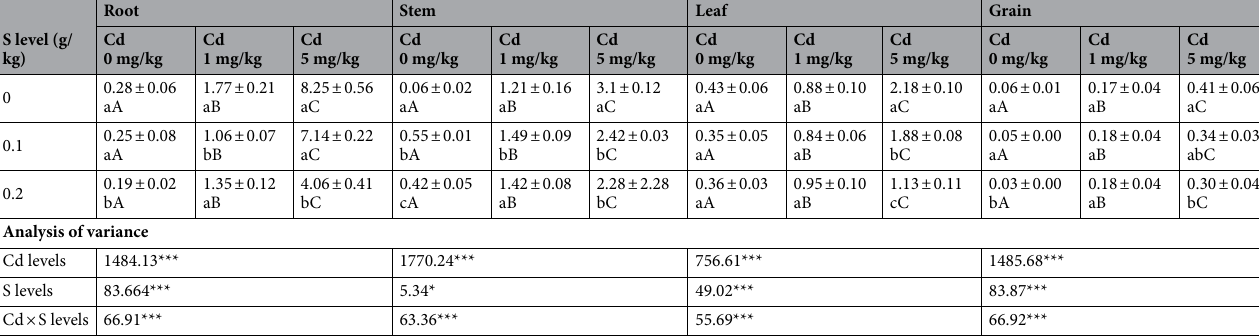
Table 1. The effect of sulfur application on Cd concentration in different tissues (mean ± S.E., n = 3). Different lowercase letters within Cd in root, stem, leaf, grain under the same Cd treatment indicates a significant difference among different S levels at P < 0.05. Different capital letters within Cd in root, stem, leaf, grain under the same S treatment indicates a significant difference among different Cd treatment at P < 0.05. Analysis of